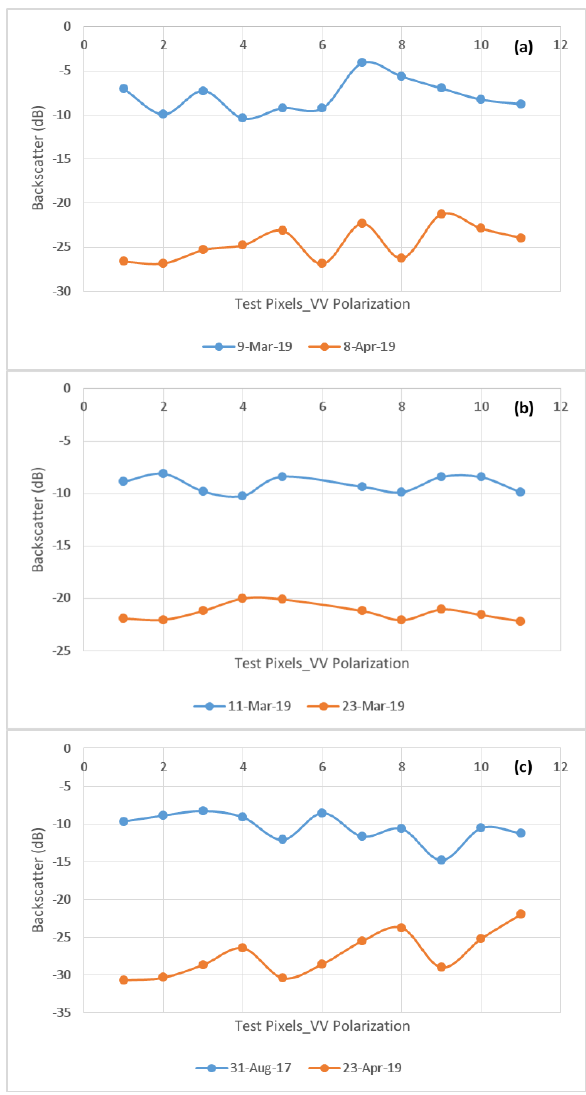
Figure 4. Backscatter values of Archive image in blue and Crisis image in orange for the study areas for VV polarization. (a) Khuzestan, (b) Golestan and (c) Lake Urmia Flood and surface water validation data obtained from Sentinel- 2 multispectral images over the study area (Figure 5). Short Wave Infrared (SWIR) multispectral band with a resolution of 20 m is used for validation purpose. SWIR acquisition mode enables access to information in the short wave infrared portion of the electromagnetic spectrum (ESA Communications). SWIR sensor with 1-3 µm wavelengths is capable to penetrate haze, smoke and thin clouds and due to its significant absorption by water is particularly useful to discriminate wet earth from dry earth and consequently for water detection and quantification (Stark, 2015). By visual interpretation and comparing of the Archive and Crisis images from the Sentinel-2 data in the Figure 5, the flood extent can be distinguished from the non- flooded areas in two flood affected provinces and water surface changes in Lake